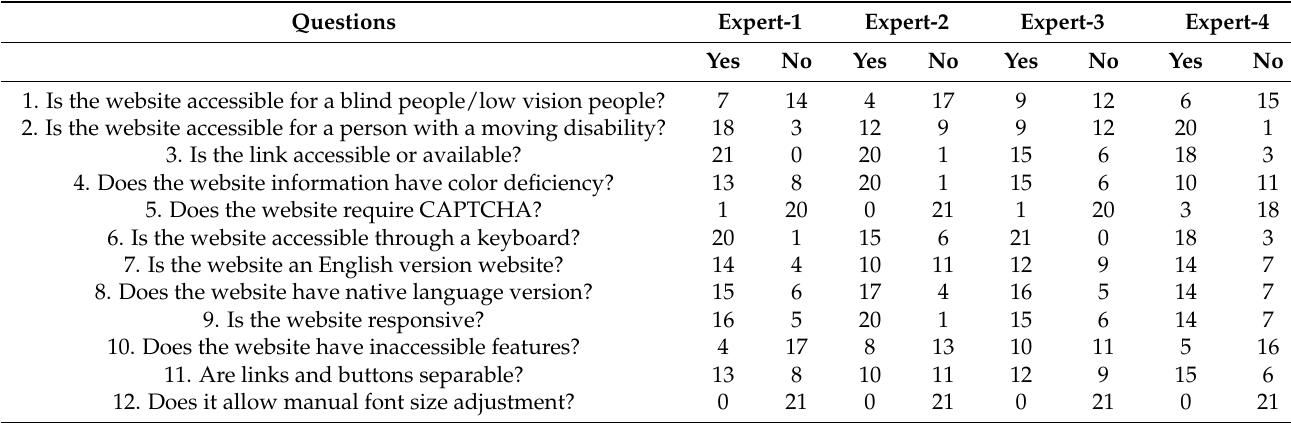
Table 11. Expert result of targeted